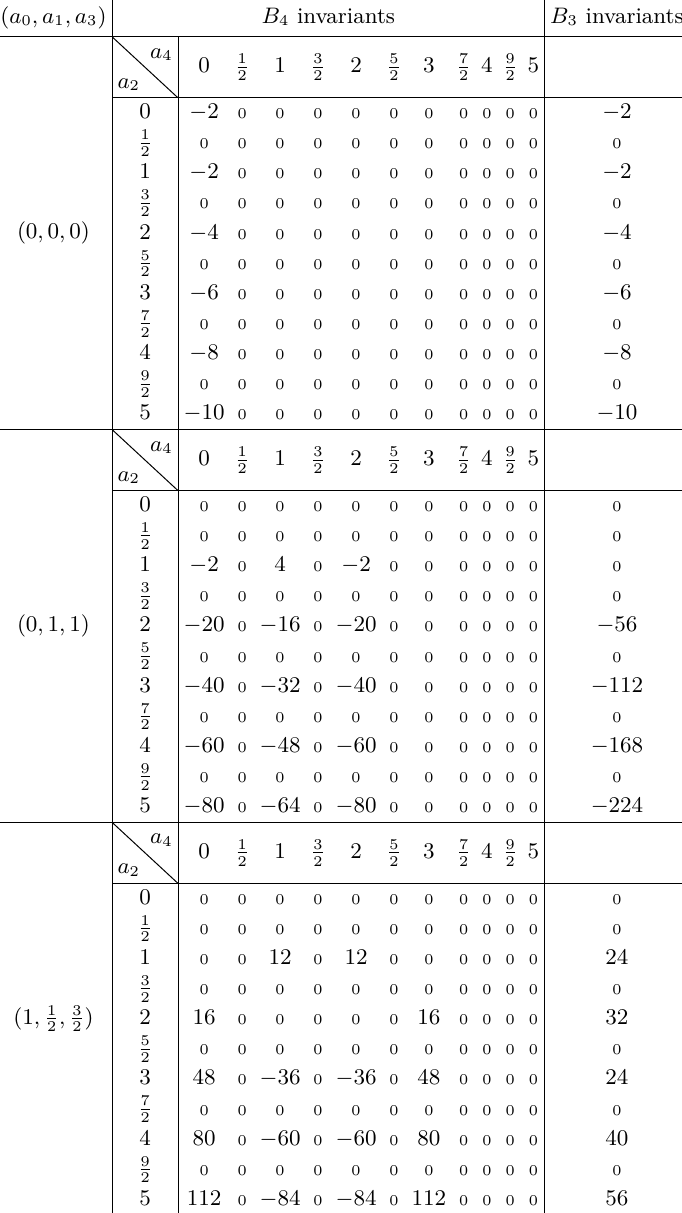
Table 4 . Genus 0 Gromov-Witten invariants for B 4 and B 3 theories over F 2 . We see that adding the rows of B , we get the B invariants in agreement with equations (3.40) and 4 3